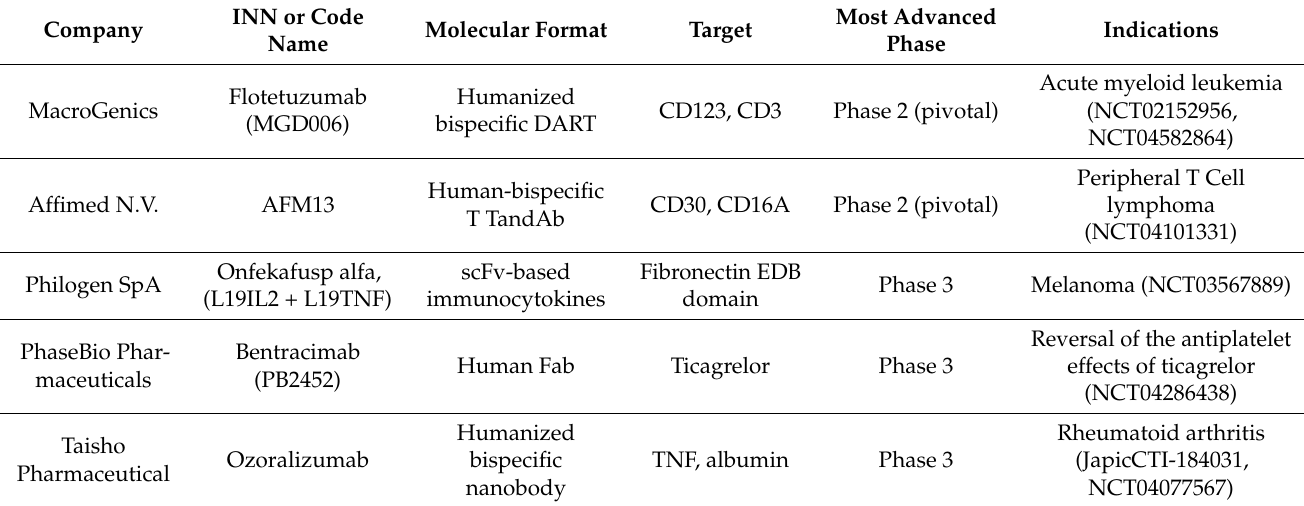
Table 2. Fc-free antibody-based therapeutics in late-stage clinical